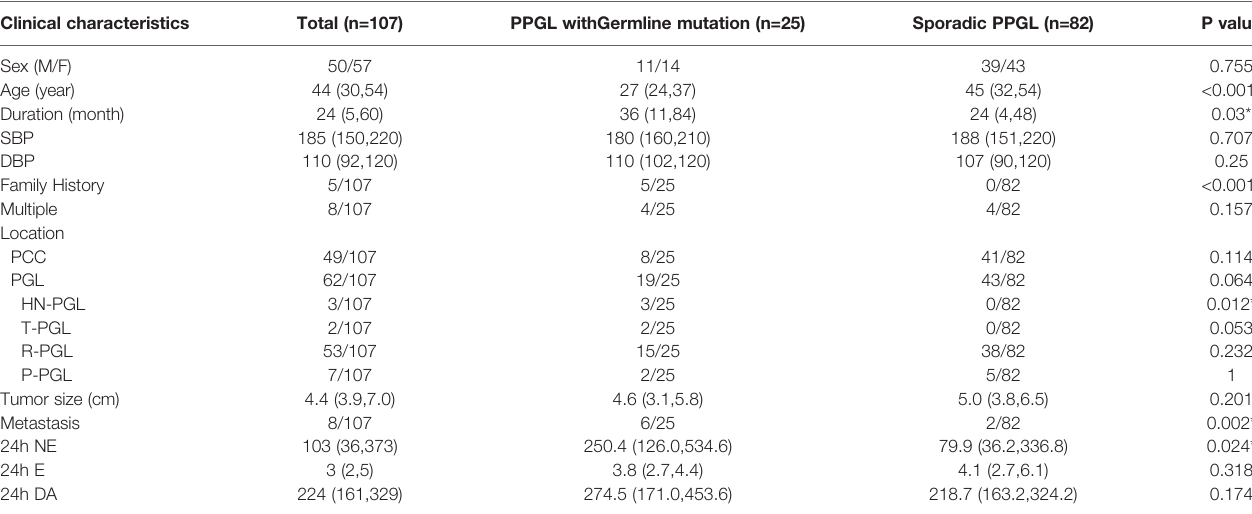
TABLE 1 | Clinical features of